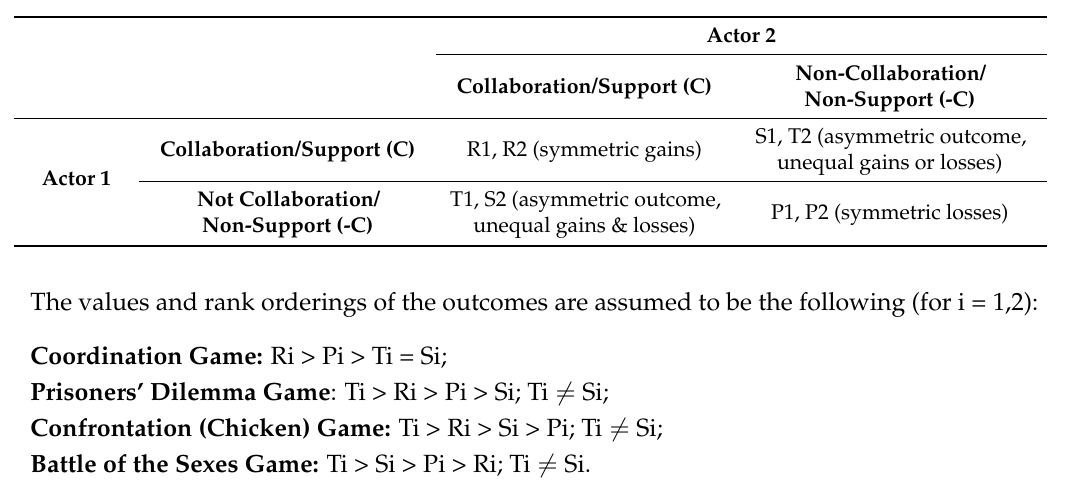
Table A2. Payoff Matrices and Definitions of Four Game